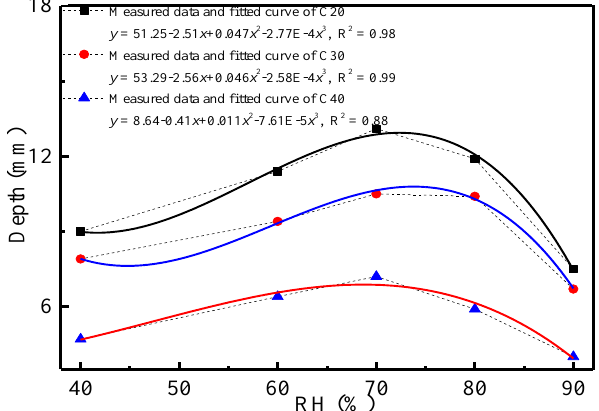
Figure 3. Relationship curve between relative humidity and the carbonation depth of concrete.